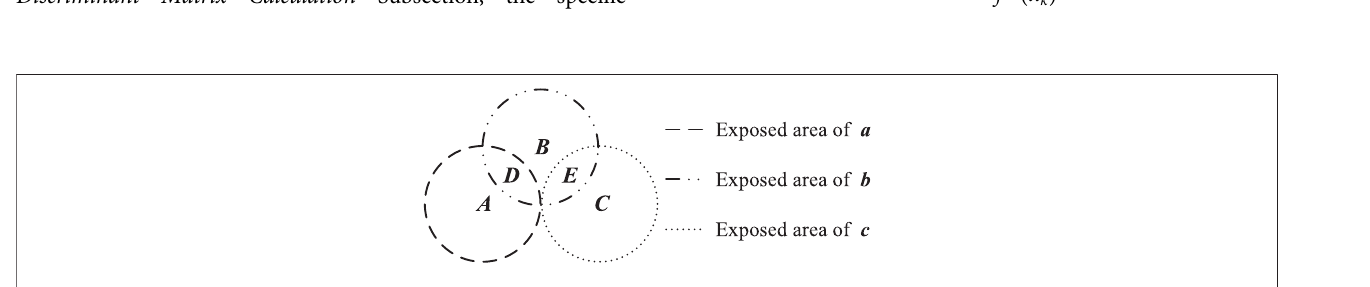
Frontiers in Energy Research |